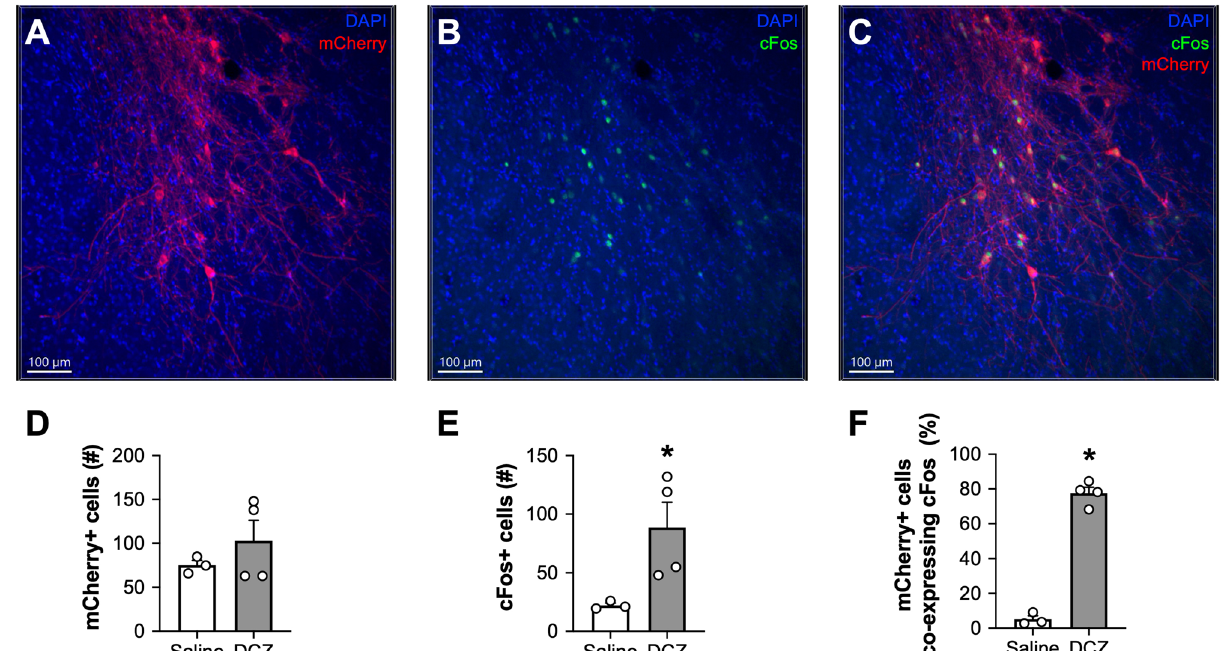
Figure 1. DCZ-mediated chemogenetic activation elicits selective cFos induction in hM3Dq-expressing Cells. Representative 10 × images of the CeA containing mCherry + ( A ), cFos + ( B ), or mCherry + /cFos + cells ( C ) following injections of 0.1 mg/kg DCZ in male Long-Evans rats expressing hSyn.hM3Dq.mCherry. The quantification of average mCherry + ( D ), cFos + ( E ), and mCherry + /cFos + ( F ) cell counts in saline and DCZ-treated rats are depicted below each image. Compared to saline controls, DCZ-injected rats exhibited significantly more cFos + cells and more mCherry + cells that co-expressed cFos. * p < 0.05; n = 3 rats for the saline group, 4 rats for the DCZ